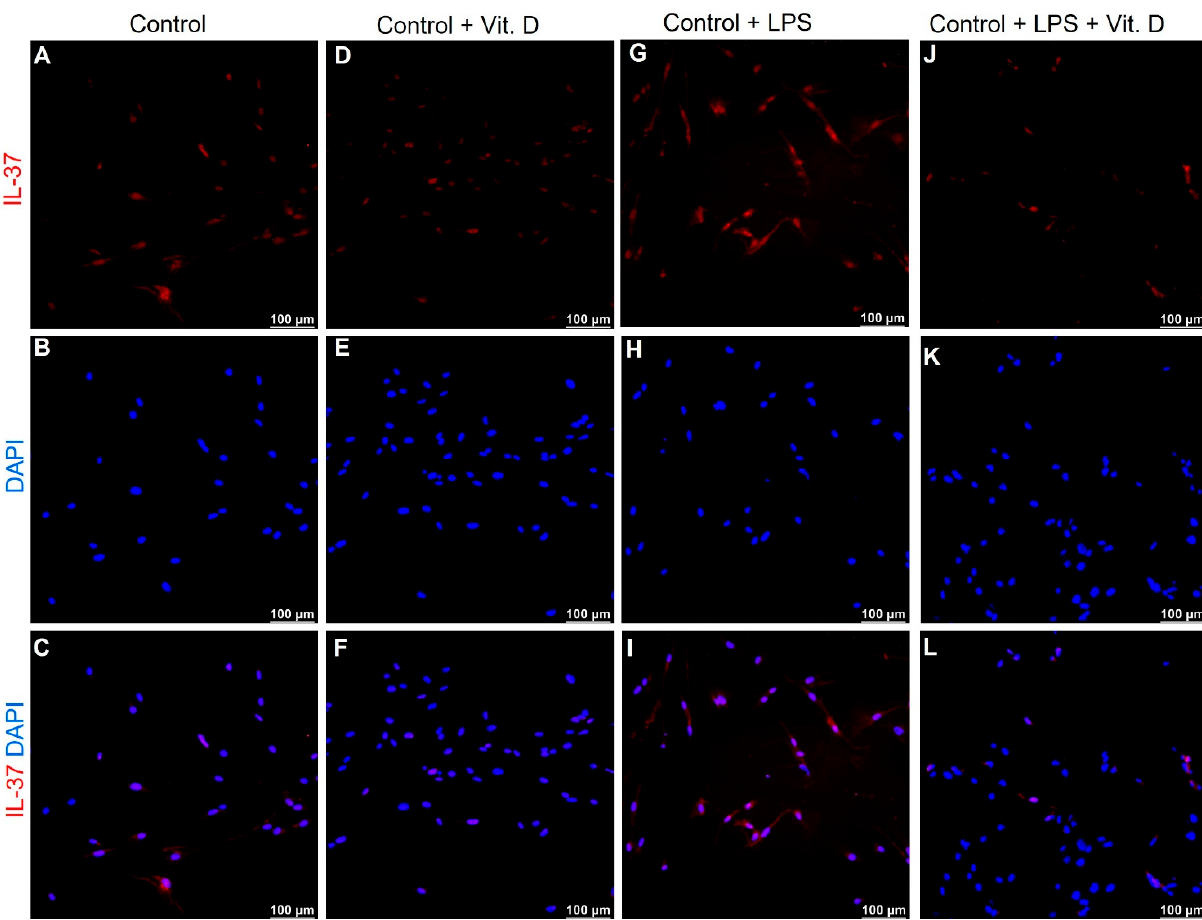
Figure 6. Immunofluorescence for IL-37 in endothelial cells (ECs). Immunofluorescence for IL-37 in control (panel A ), calcitriol treated ECs (panel D ), lipopolysaccharide (LPS) treated ECs (panel G ), and calcitriol + LPS treated ECs (panel J ); 4 ′ ,6-diamidino-2-phenylindole (DAPI, panels B , E , H , and K ); merged images (panels C , F , I , and L ).